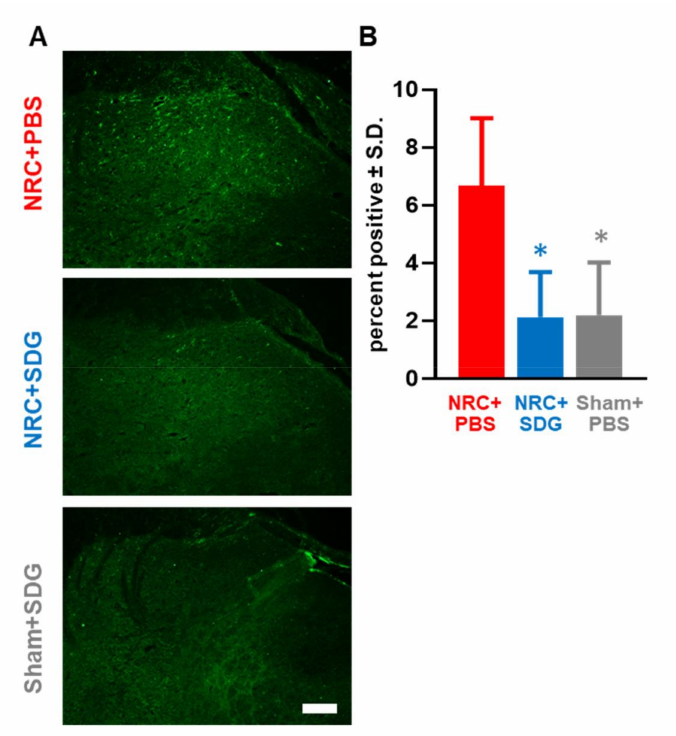
Figure 5. ( A ) After painful NRC, increased spinal nitrotyrosine expression is evident with PBS treatment but is lower after SDG treatment and similar to sham levels, as shown in representative images. The scale bar is 100 µ m and applies to all panels. ( B ) Spinal nitrotyrosine levels after SDG treatment (* p = 0.0006) are significantly reduced to sham-treated levels. Spinal nitrotyrosine levels for a rat treated with SDG but undergoing a sham surgery are also significantly lower (* p = 0.0001) than the NRC + PBS